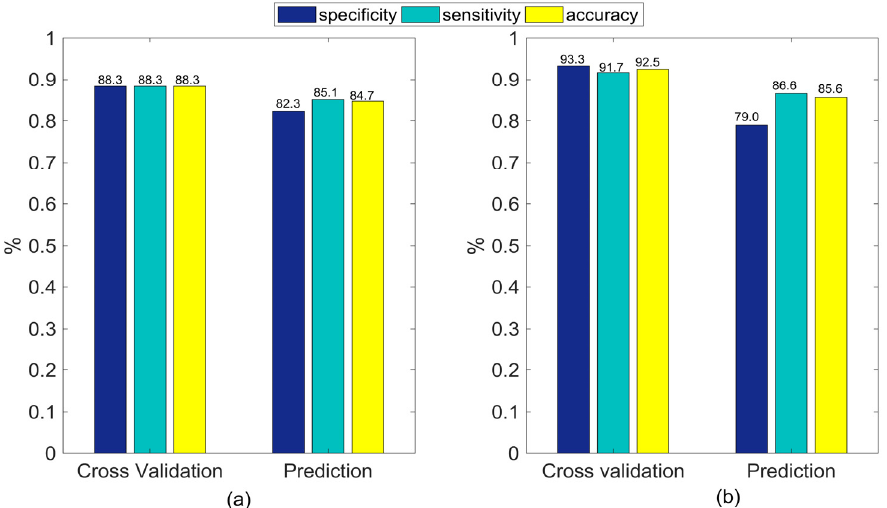
Figure 6. ( a ) PLS-DA and ( b ) SVM classification results of classifiers for distinguishing bruised samples based on the fusion of push based and LCTF based HSI in data level.